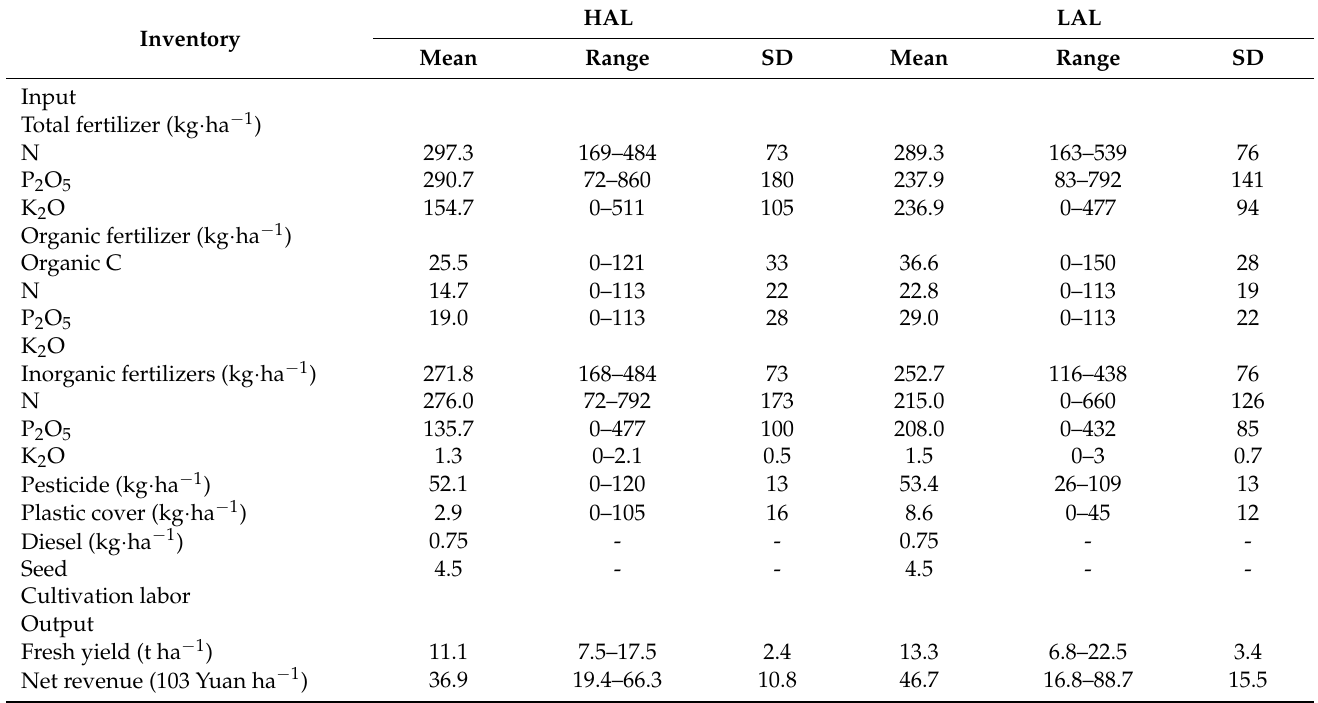
Table 2. The resource inputs and output for pepper cultivation in HAL and LAL. HAL represents